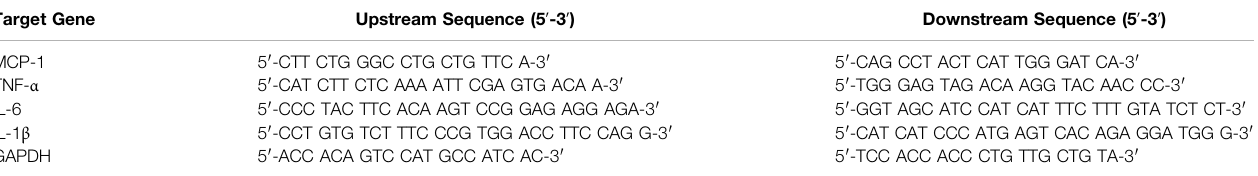
TABLE 1 | The primer sequences used for real-time PCR. Target Gene Upstream Sequence (5 ʹ -3 ʹ ) Downstream Sequence (5 ʹ -3 ʹ )